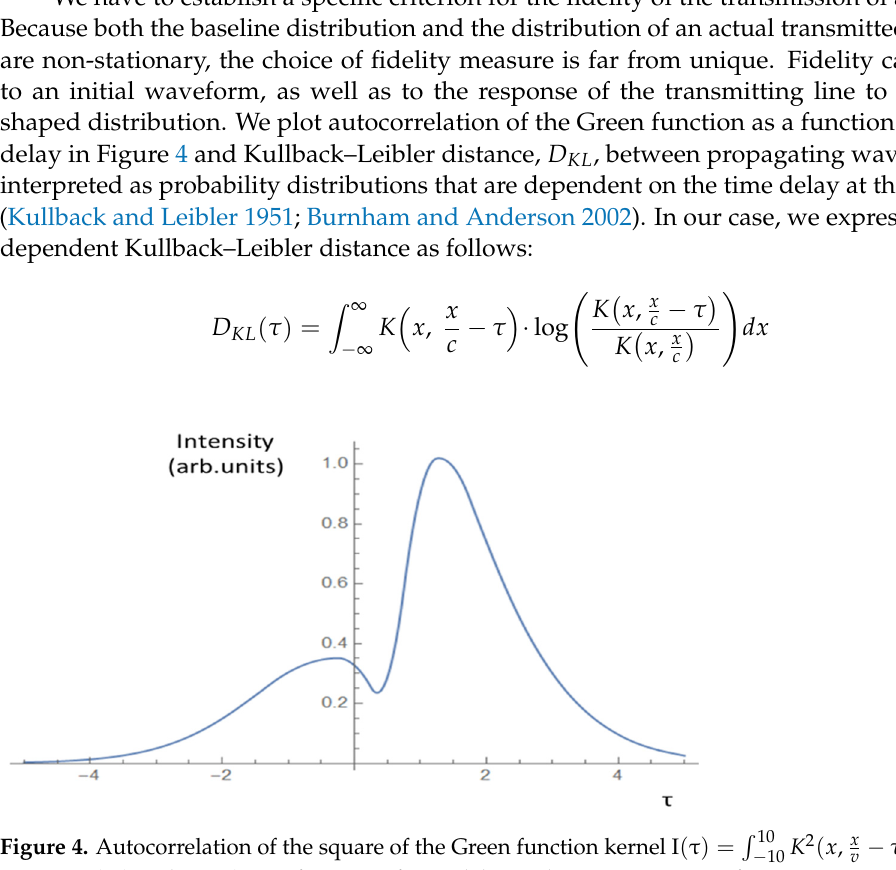
Figure 4. Autocorrelation of the square of the Green function kernel I ( τ ) = (cid:1516) (cid:1837) (cid:2870) ((cid:1876), (cid:3051) (cid:3049)(cid:2869)(cid:2868) Equation (14) in the text), as a function of time delay and v = 0.75 c . Limits of integration are arbitrary as a truncation to approximate [ − ∞ , + ∞ ] with the necessary accuracy.